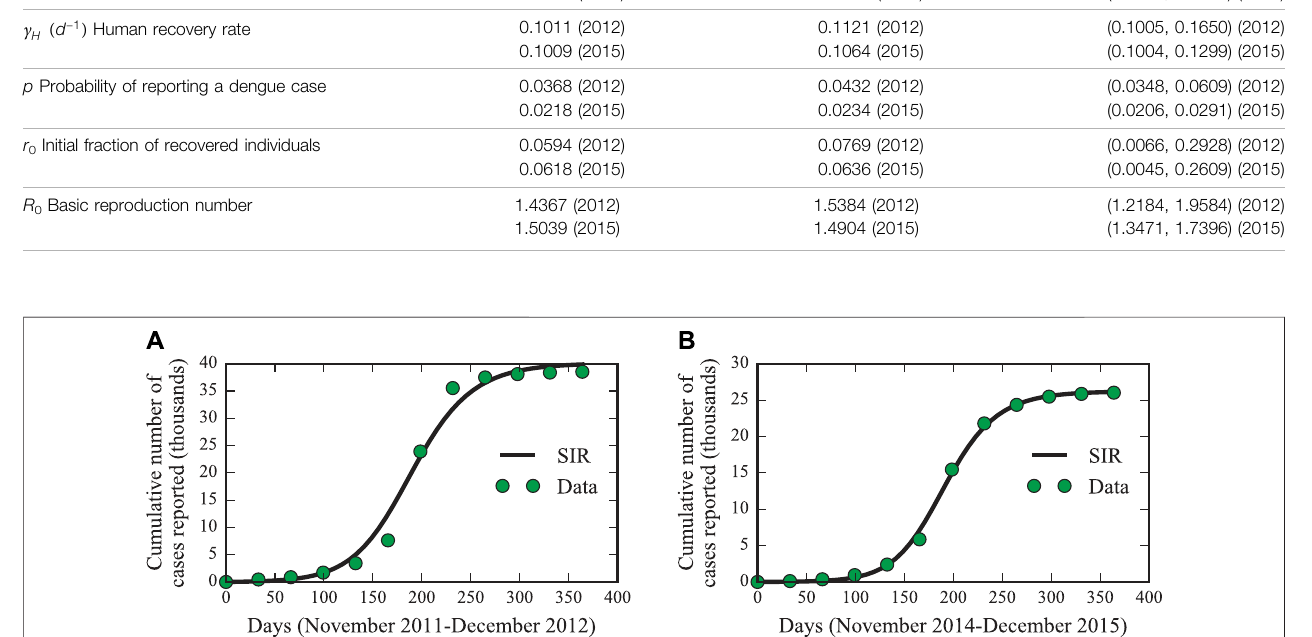
Frontiers in Physics |